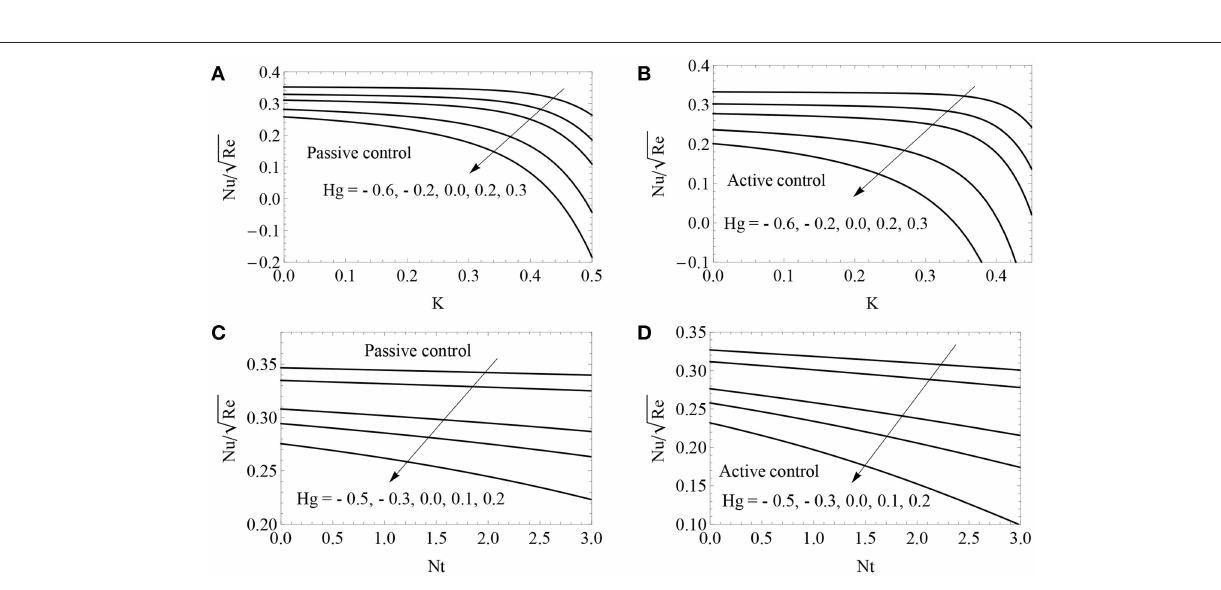
0.1, c 0.5 and Bi = = =